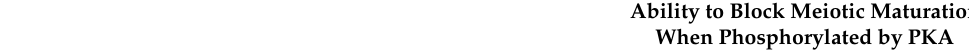
Table 2. PKA-substrates in Xenopus prophase-arrested oocytes (Prophase I). Summary of the features of the PKA substrates identified so far. OA: Okadaic Acid (pharmacological inhibitor of PP2A-B55 δ , the phosphatase counteracting active MPF). MPF injection refers to the injection of cytoplasm from metaphase II-arrested oocytes [1].